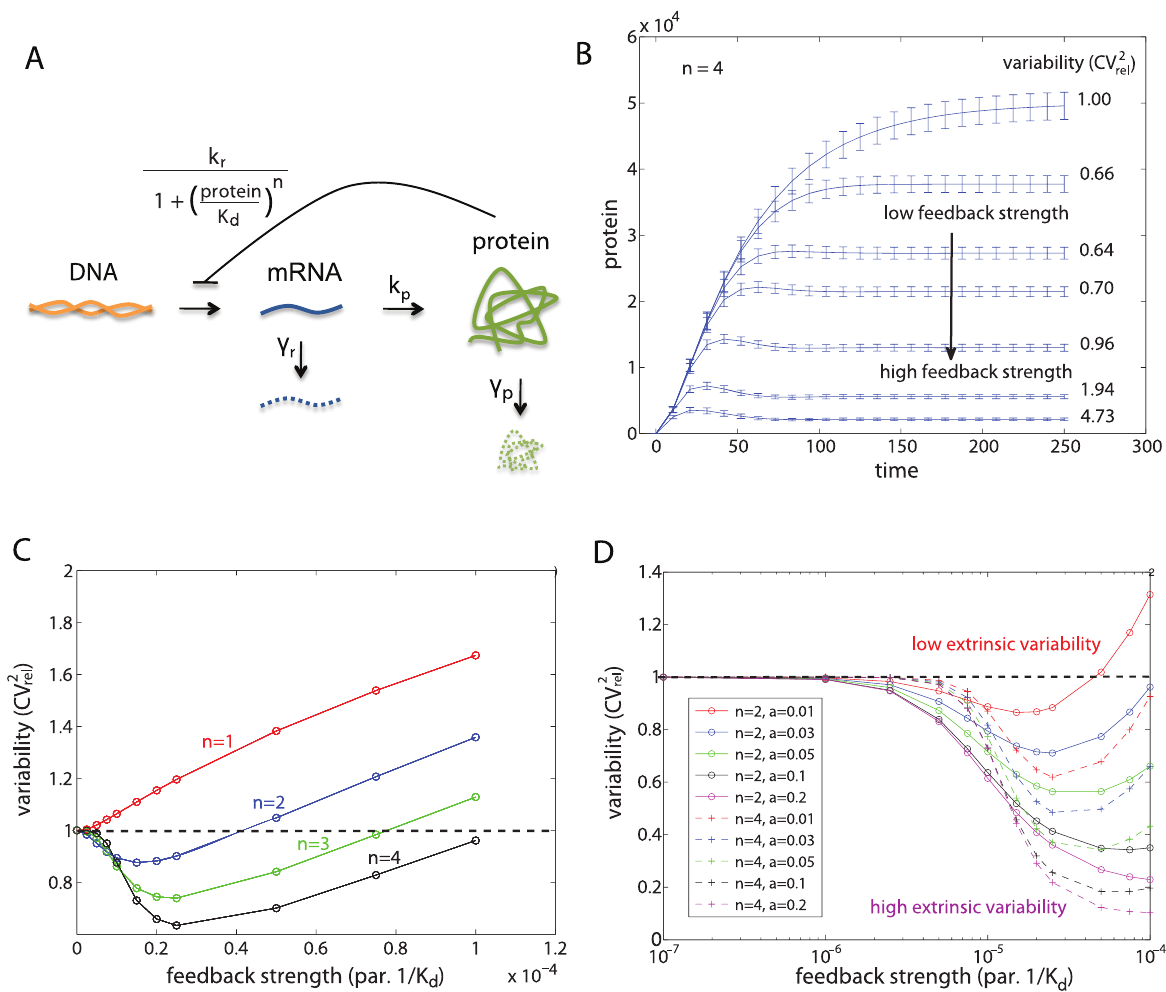
Figure 4. Results for the single gene expression model. (A) Single gene expression model with transcriptional self-repression. (B) Examples of protein distribution dynamics under no feedback (top-most) and under negative feedback. Increased feedback strength ( 1 = K d ~ 0,2 | 10 { 5 ,3 : 5 | 10 { 5 ,5 | 10 { 5 ,10 { 4 ,3 | 10 { 4 ,10 { 3 top to bottom) resulted in lower means and variances. Reported are the measures of variability calculated for the steady-state distribution with Hill coefficient n ~ 4 . (C) Effect of self-repression on variability when intrinsic stochasticity is the only source of variability, for Hill coefficient values of n ~ 1, ... ,4 . (D) Effect of self-repression on the system with both intrinsic and extrinsic variability. Extrinsic variability is introduced into the transcription rate. Extrinsic variability in parameters (eqn. (13)): a ~ 0 : 01 (red), a ~ 0 : 03 (blue), a ~ 0 : 05 (green), a ~ 0 : 1 (black), a ~ 0 : 2 (magenta) with Hill coefficient n ~ 2 (full line; o), n ~ 4 (dashed line; + ).